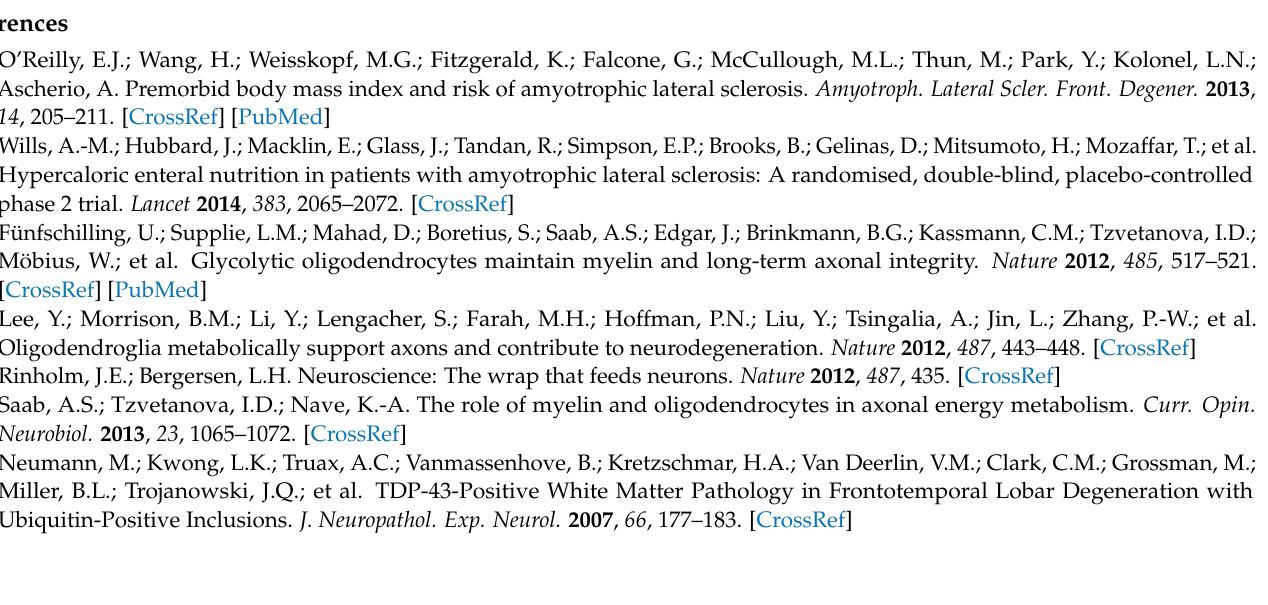
ALS versus control; Figure S2: A schematic diagram demonstrating the relationship between identi- fied lipids and their asso-ciated enzymes; Figure S3: There is less regulation of cholesterol metabolism in ALS; Figure S4: There is significant difference in the expression of key lipid metabolizing enzymes relative to their respective lipid species in ALS; Figure S5: There is no difference in the density of OLIG2+ oligodendrocytes in the motor cortex white matter in ALS compared to